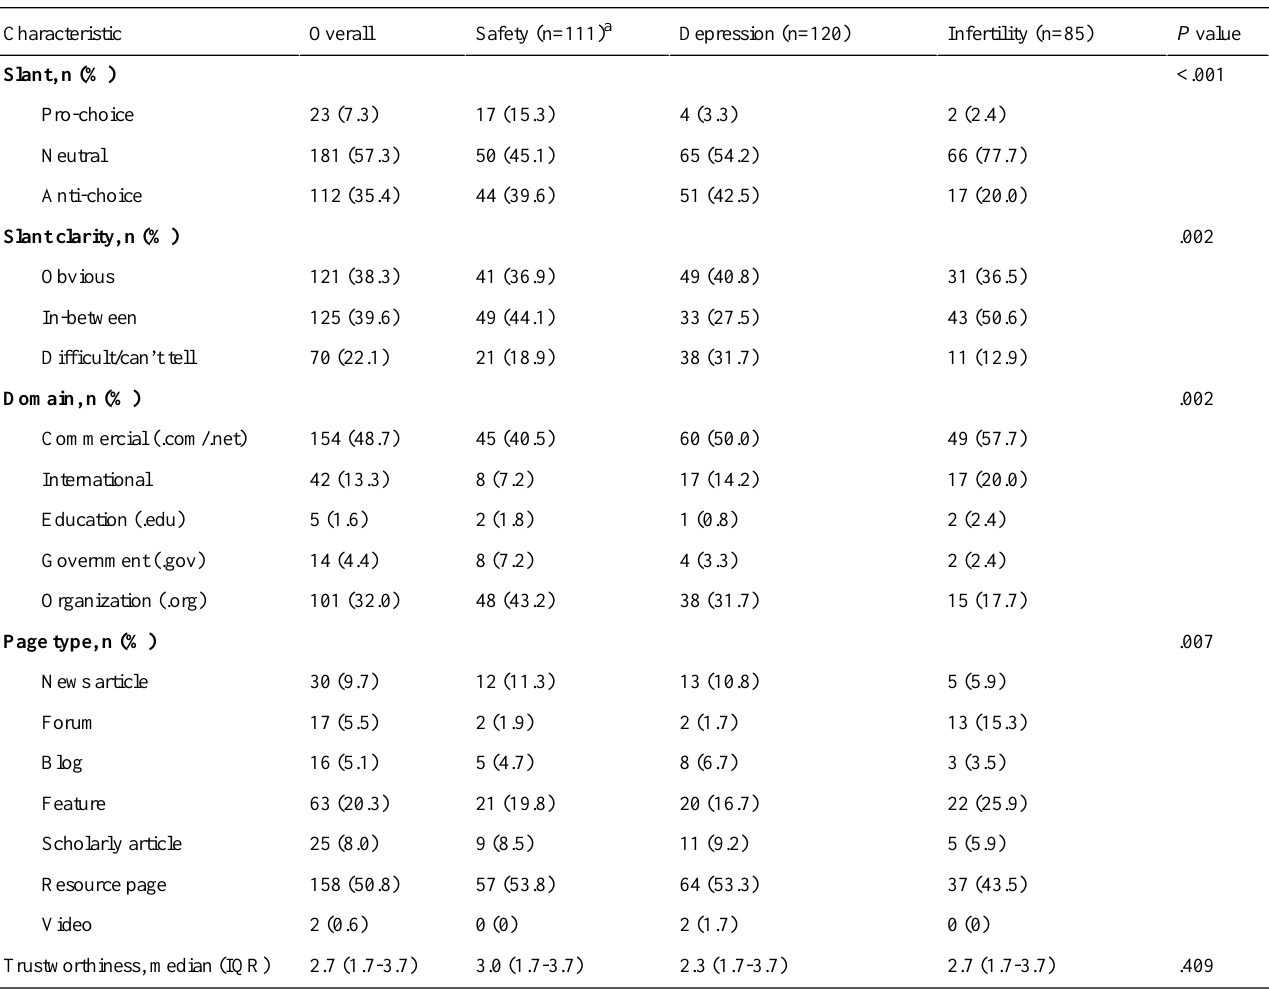
Table 1. Website characteristics by search topic